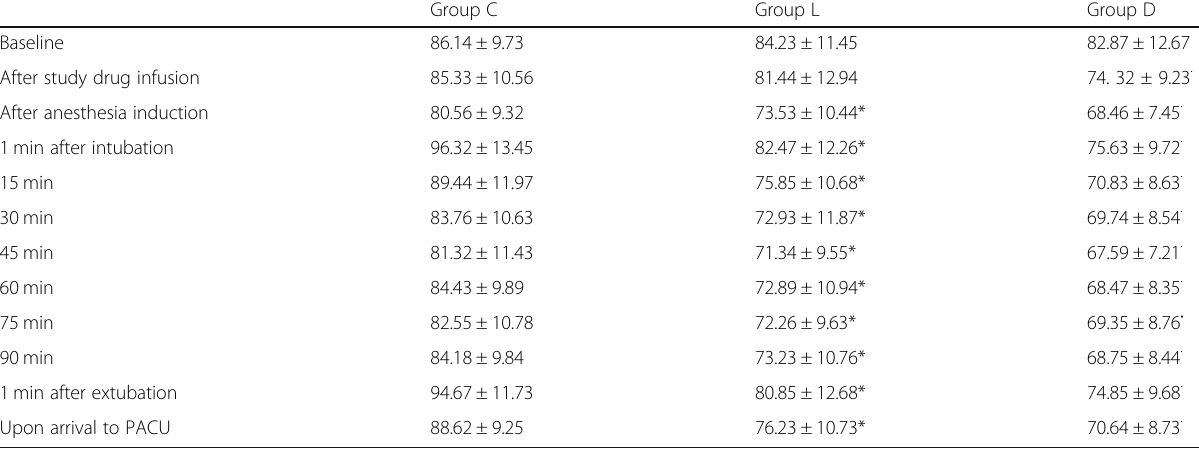
Table 3 Heart rate (beat/min) changes in the study groups (data are presented as mean ± SD)